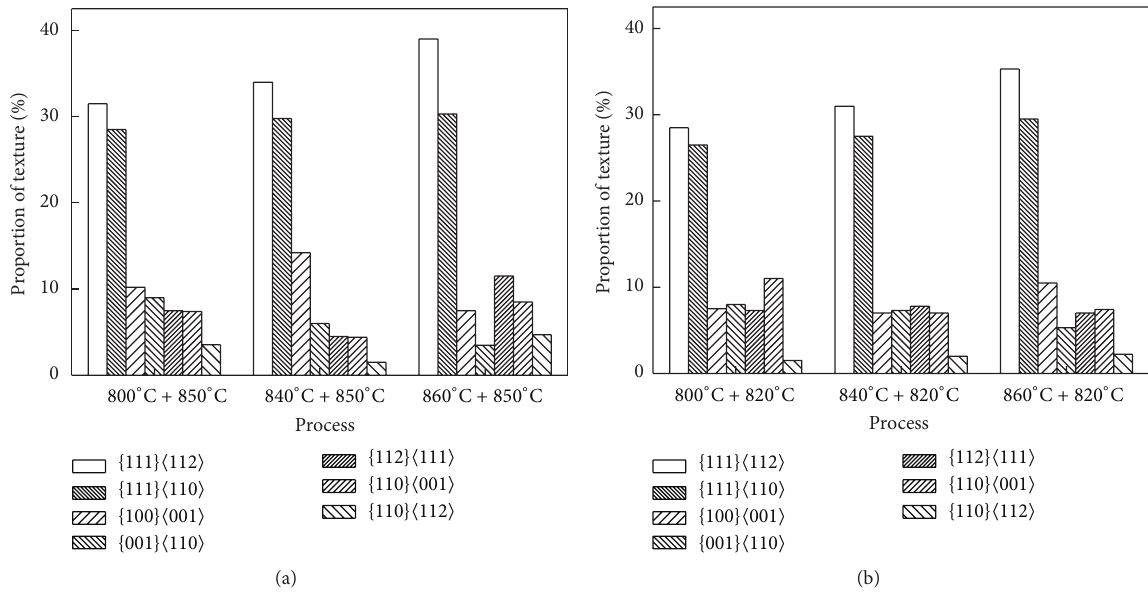
Figure 4: Proportions of typical textures in primary recrystallization samples under different intermediate annealing processes: (a) test group of samples intermediately annealed at 850 ∘ C; (b) test group of samples intermediately annealed at 820 ∘